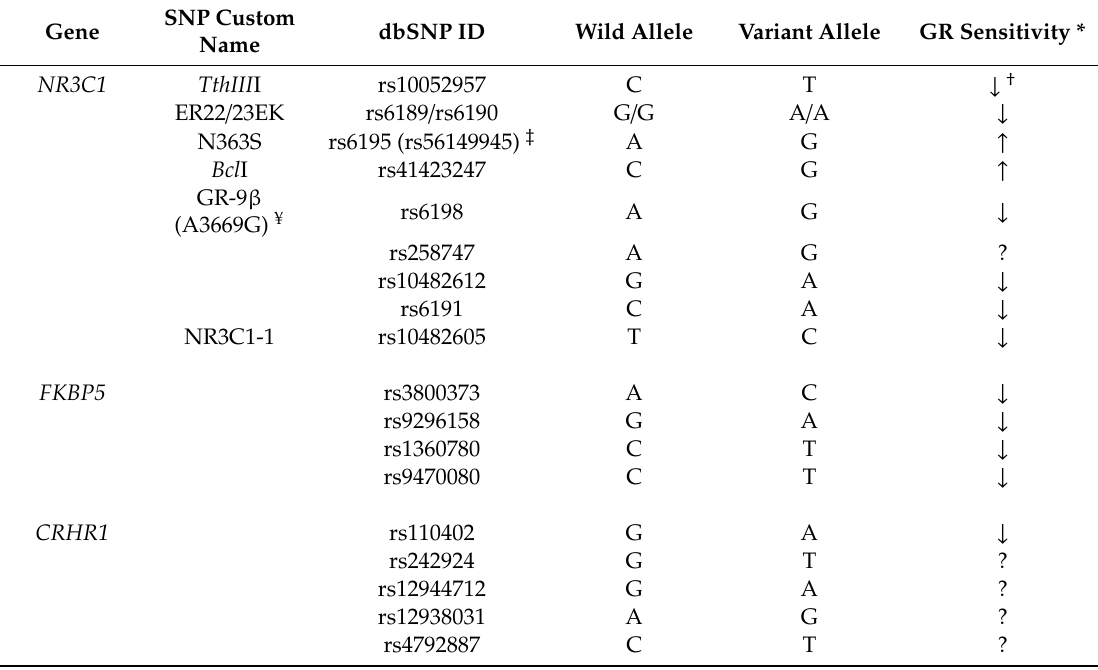
Table 1. Single nucleotide polymorphisms (SNPs) of the NR3C1 , FKBP5 , and CRHR1 genes which have been associated with post-traumatic stress disorder (PTSD) or which have altered sensitivity of the hypothalamus–pituitary–adrenal